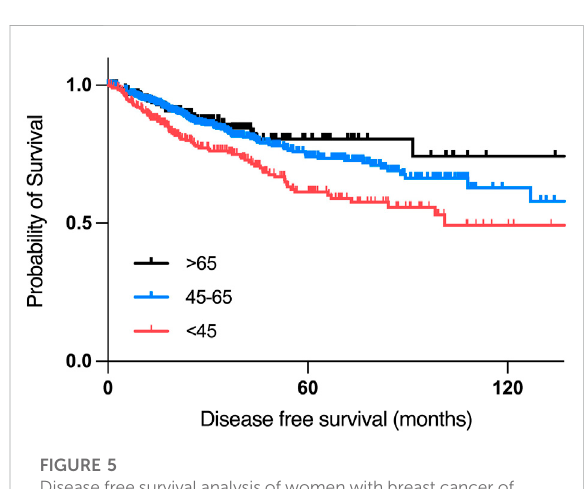
FIGURE 5 Disease free survival analysis of women with breast cancer of different age